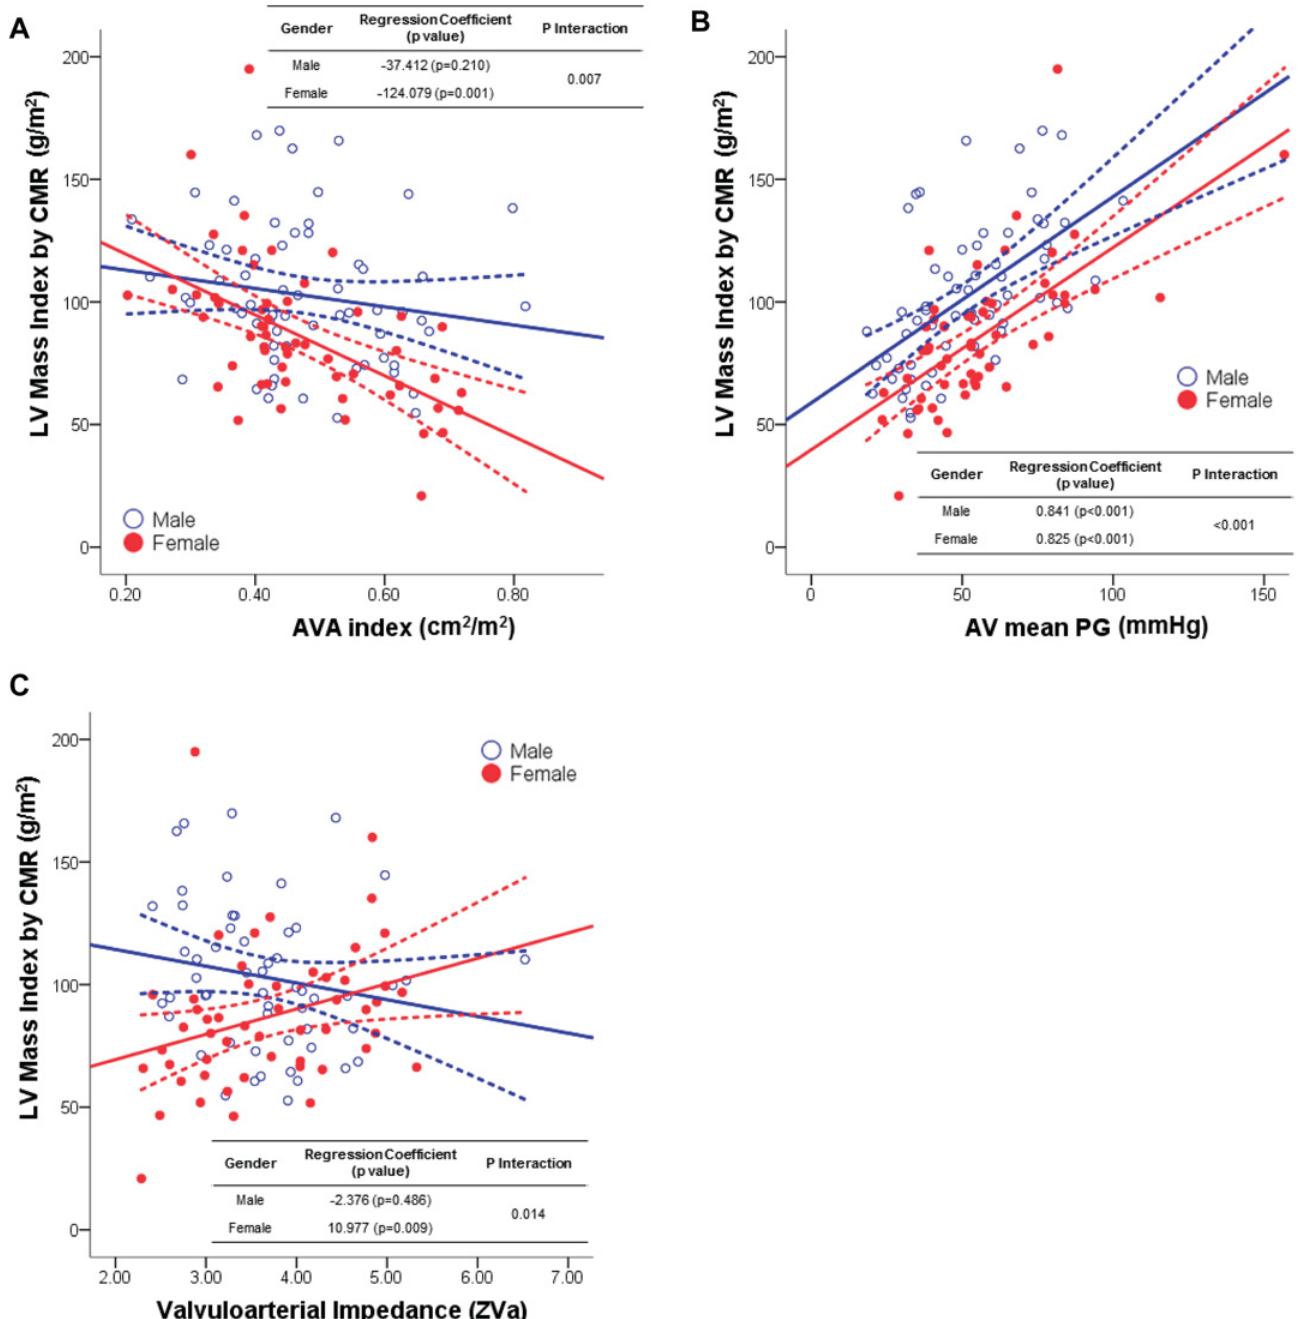
Fig 1. The association between left ventricular mass index and the severity of aortic stenosis or valvuloarterial impedance. Males consistently showed relatively higher left ventricular mass index in (A) larger aortic valve area index, (B) lower mean transaortic pressure gradient, or (C) lower valvuloarterial impedance, compared with females. However, there were significant differences between the two genders in the degree of correlation between the left ventricular mass index and the above three parameters. The univariate linear regression coefficient and the interaction p-value across the gender are shown. Abbreviations: AV, aortic valve; AVA, aortic valve area; CMR, cardiovascular magnetic resonance; PG, pressure gradient.